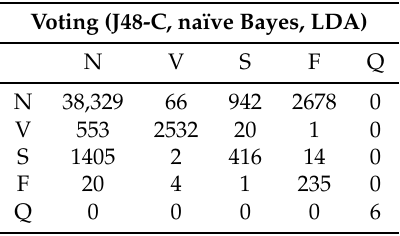
Table 14. Confusion matrix for combining J48-C, naïve Bayes, and LDA classifiers using a Voting scheme.